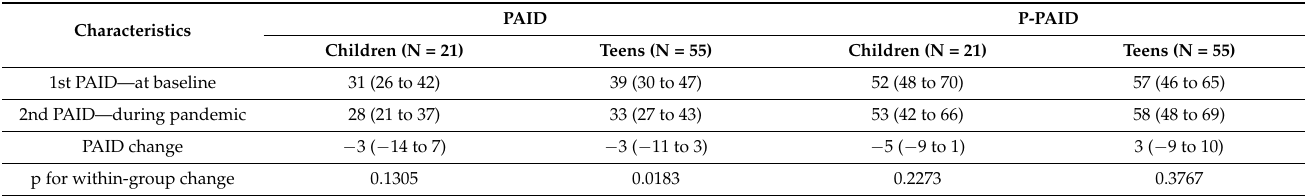
Table A3. Diabetes-related distress expressed as PAID scores before (baseline, i.e., 1st PAID) and during pandemic (2nd PAID) in children, teens and in their parents. Median values (and Q1–Q3) are presented.